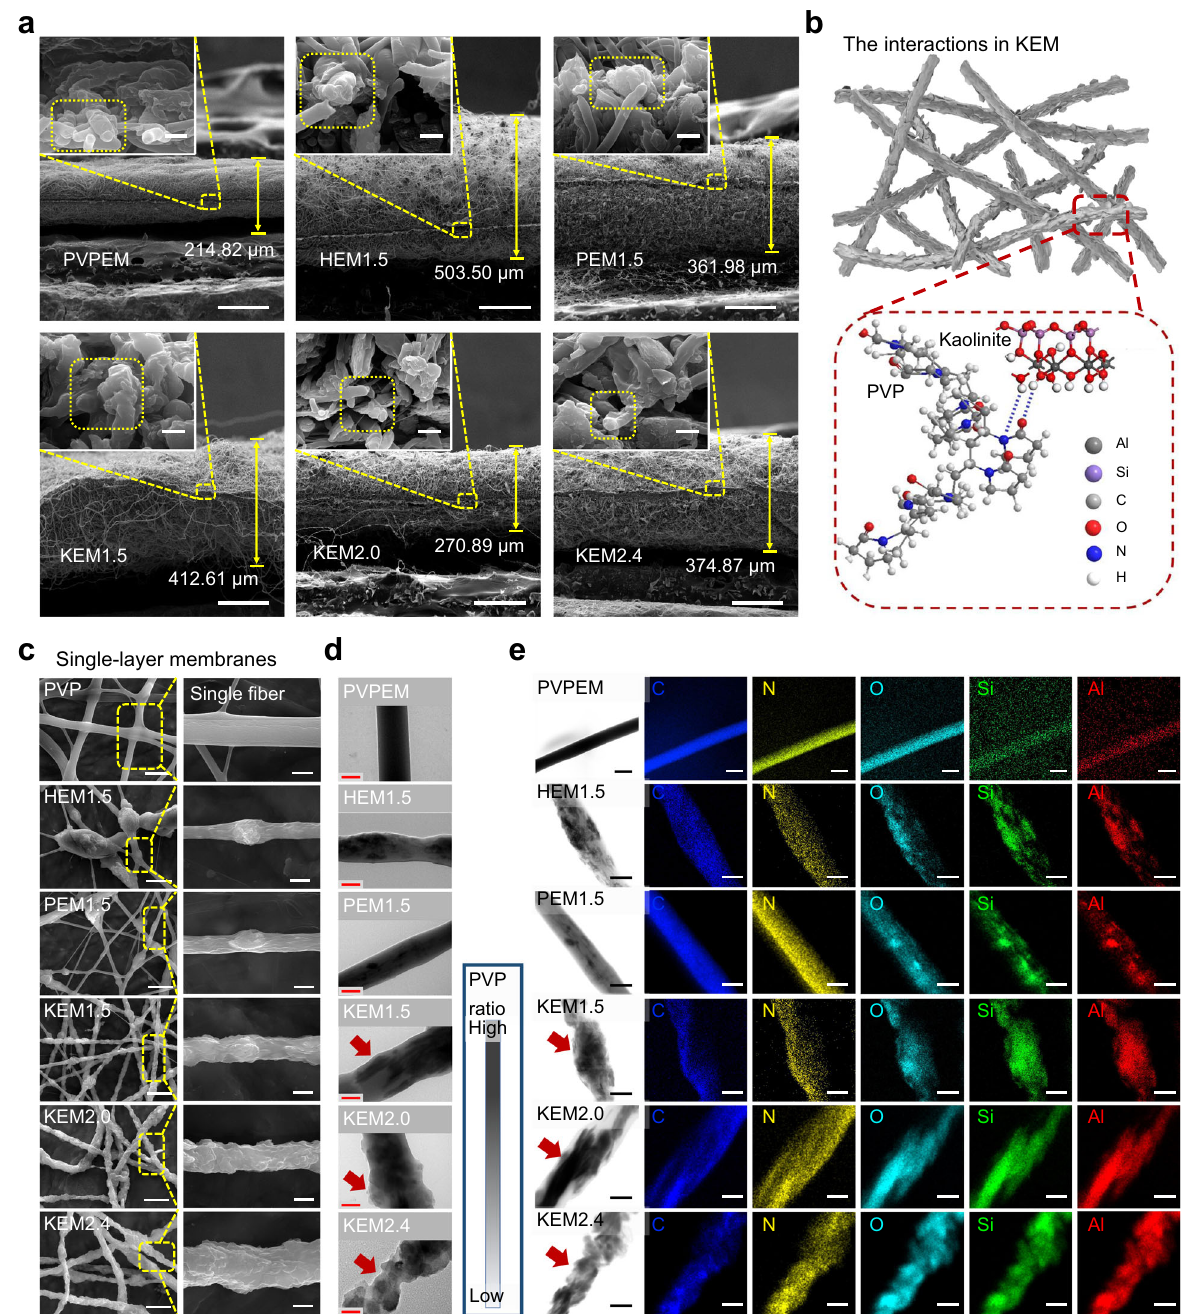
Fig. 2 The inner morphology, interactions and dispersion characteristics for nanoclay membranes. a Cross-section SEM images of PVPEM, HEM 1.5 , PEM 1.5 , KEM 1.5 , KEM 2.0 , and KEM 2.4 . Scale bar, 2 µ m. The inset in ( a ) are the corresponding magni fi ed SEM images of fi ber section. Scale bars in the insets of ( a ), 2 μ m. b The illustration of the bonding interaction between kaolinite and PVP. c The SEM images of single-layer membranes (including the single fi ber in the inset), ( d ) TEM and ( e ) mapping analysis images for PVPEM, HEM – e ) 1.5 , PEM 1.5 , KEM 1.5 , KEM 2.0 , and KEM 2.4 , respectively. Scale bars in ( c were 10 μ m, 0.5 μ m and 1 μ m, respectively. Scale bars in the insets of ( c ), 2 μ m. Data were analyzed from at least three independently experiments in ( a ) and ( c – e ). Source data are provided as a Source Data fi